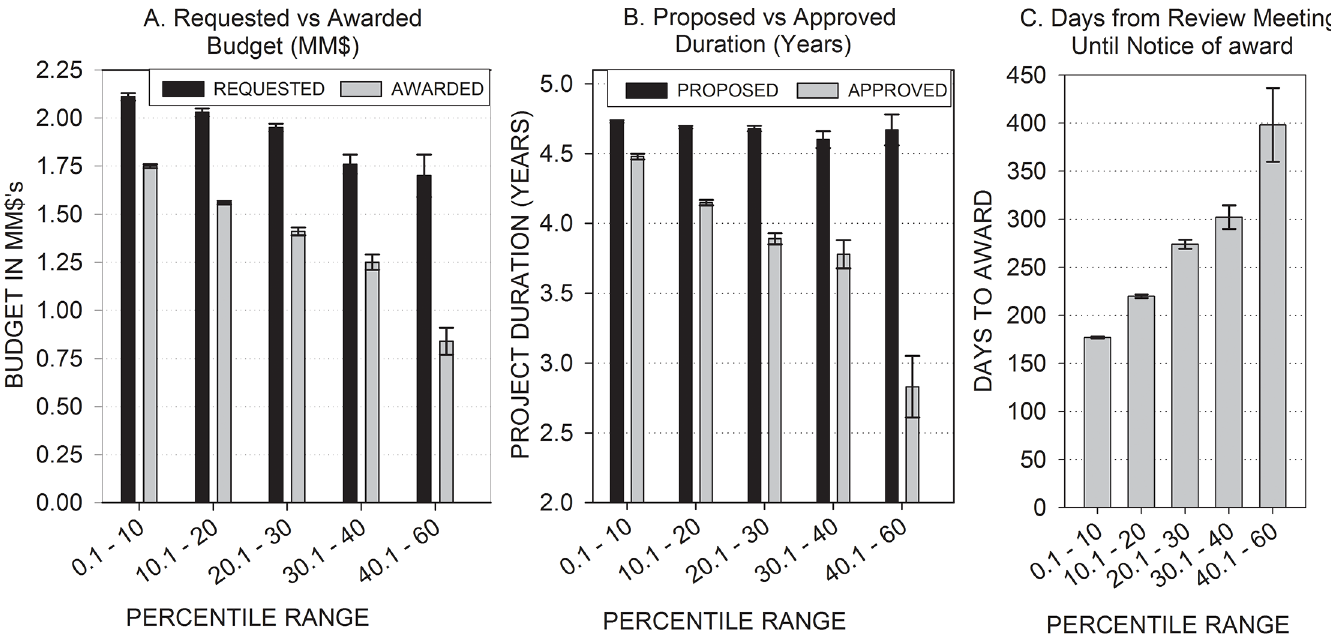
Fig 2. Awarded applications are classified by the range of percentile scores: 0.1 – 10 (N = 3,169), 10.1 – 20 (N = 2,486), 20.1 – 30 (N = 961), 30.1 – 40 (N = 178), and 40.1 – 60 (N =